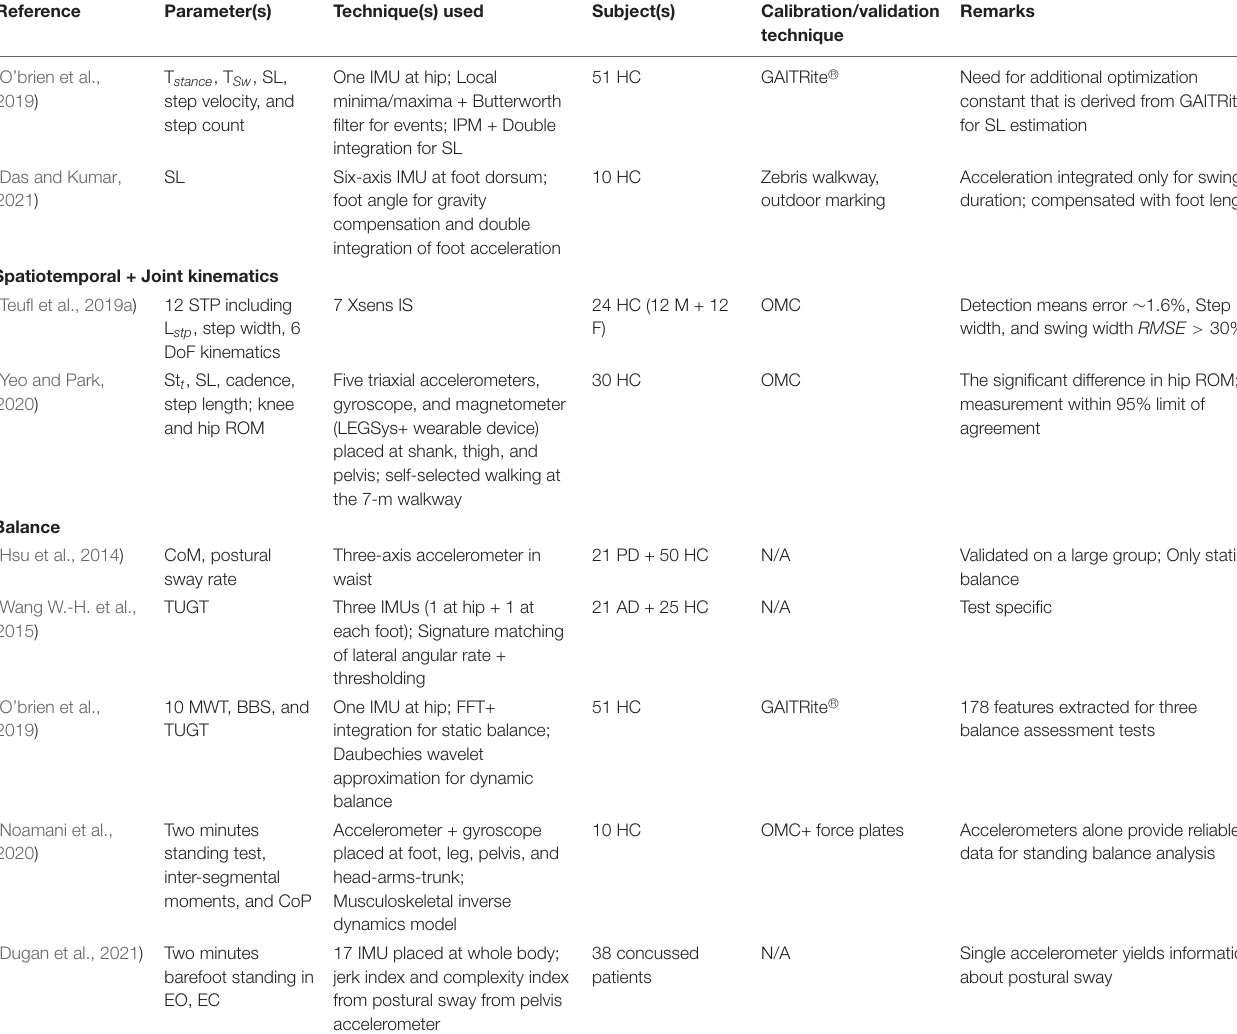
178 features extracted for three balance assessment